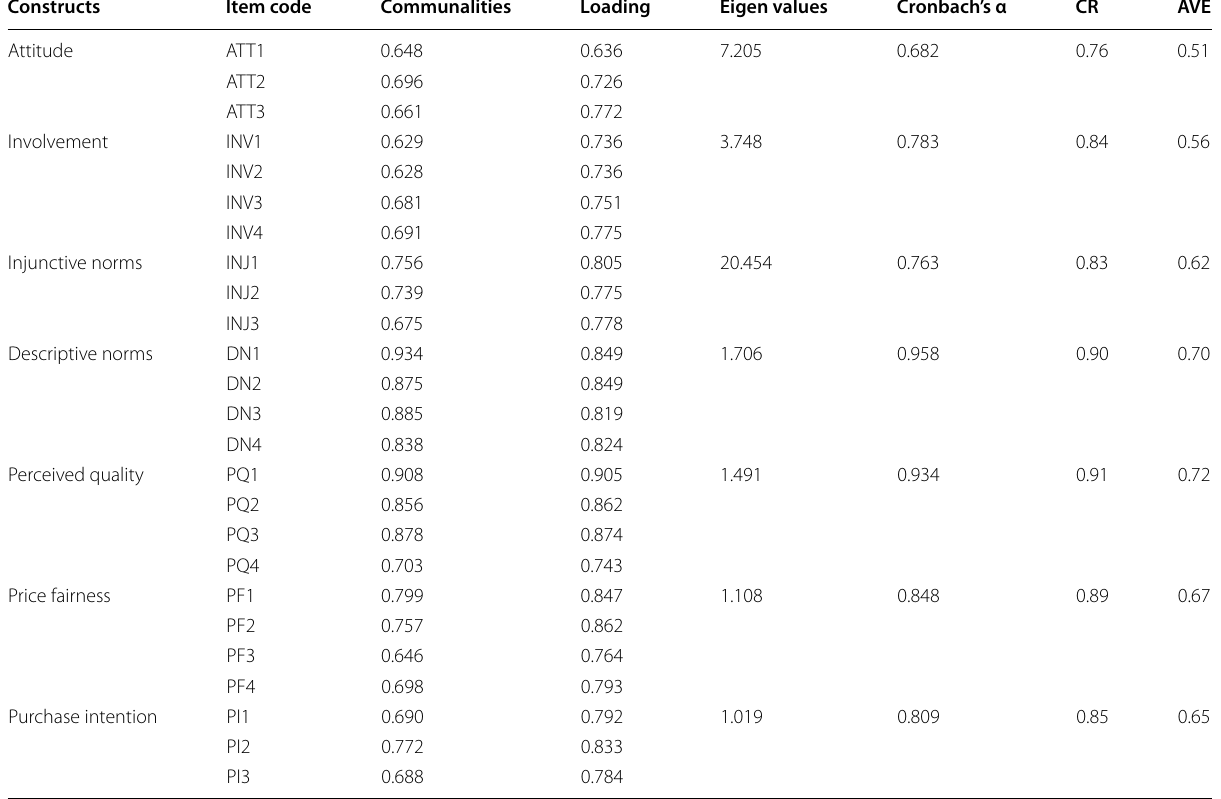
Table 4 Reliability and validity of data